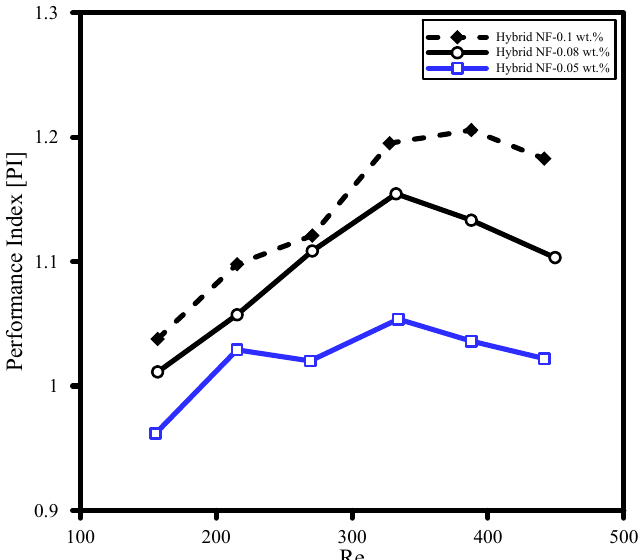
Figure 20. Performance index for water-based hBN/CF-CNTs with varying particle concentrations and various flow rates .